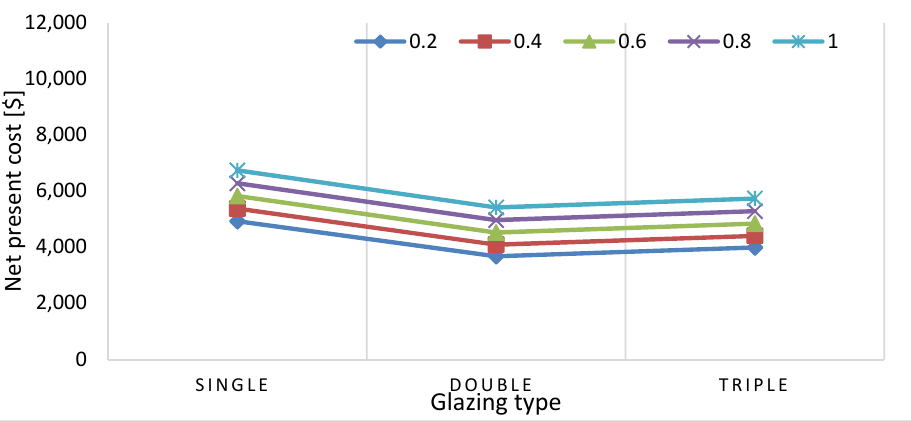
was investigated. The values of the infiltration rate were incremented between 0.2 and 1